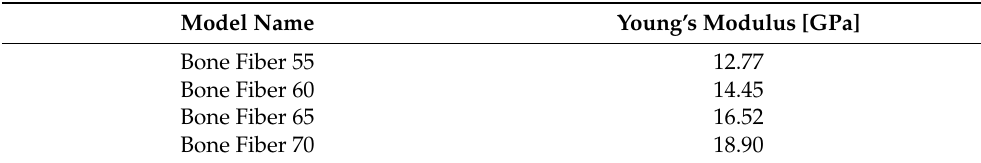
Figure 11. Stress–strain curves computed for the devised models, and their respective linear regression. A simple linear regression based on least squares using scipy.optimize.curve_fit [67] was used to compute the lines that fit the elastic region of the models (adopted as the region between 1 and 7% of strain), and consequently the estimatives of Young’s Modulus values, defined as the slope of the lines. Table 5 displays the estimated Young’s Modulus values for the devised Fiber models. Table 5. Computed Young’s Modulus values for devised Bone Fiber